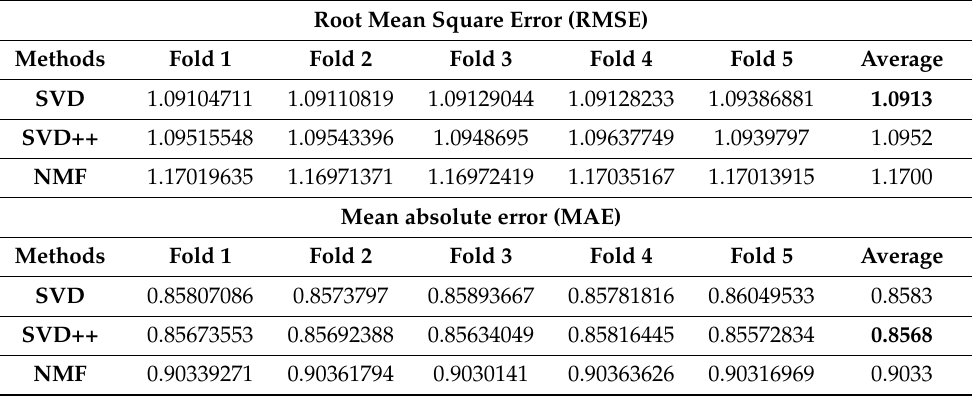
Table 4. Performance comparison of the recommendation methods, based on the RMSE and MAE metrics.